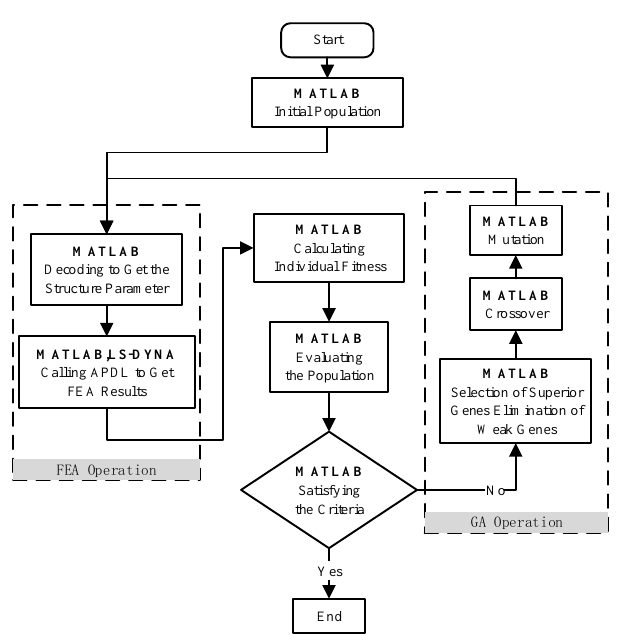
Figure 20. Basic flow chart of the algorithm.